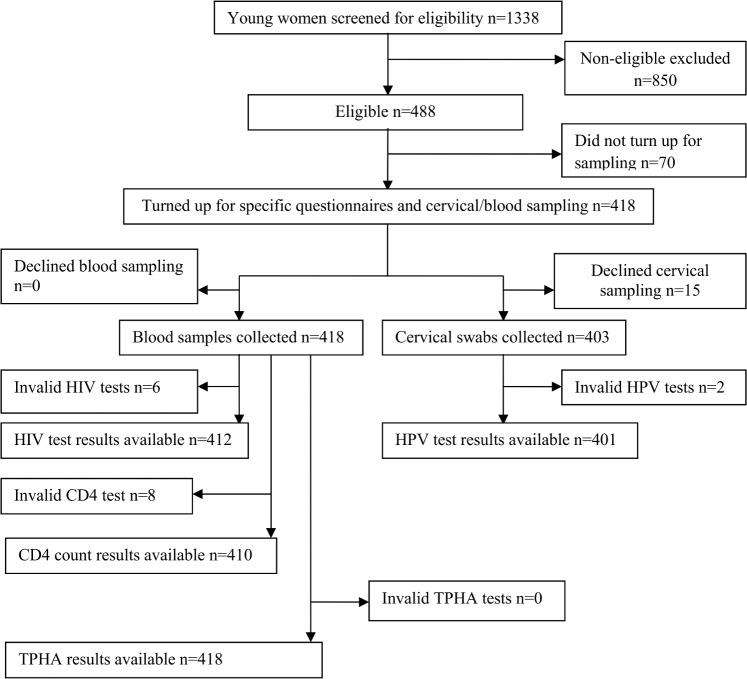
Participants flow and procedures in the study.n is the number of participants; CD4 is CD4+ T cells and TPHA is Treponema pallidum Hemagglutination assay, the test for syphilis.